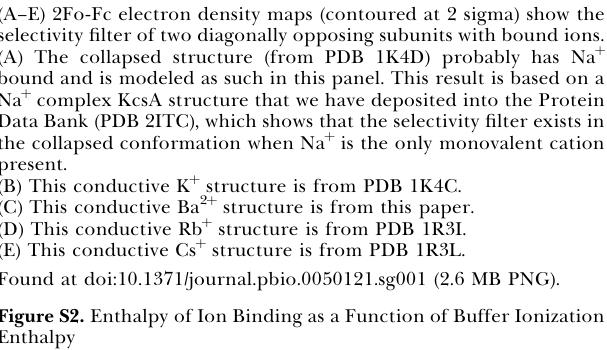
Figure S1. Structures of KcsA with Various Ions Bound within the Selectivity Filter